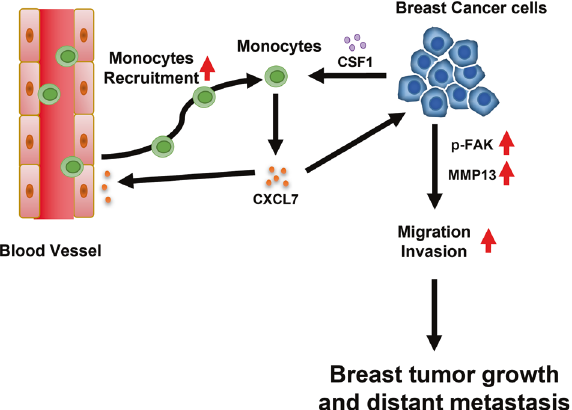
Fig. 6 Current working model of the crosstalk between breast cancer cells and monocytes in the TME. Breast cancer cells secrete CSF1 to stimulate monocytes to secrete CXCL7. CXCL7 subsequently recruits monocytes into the TME and enhances invasive behavior in breast cancer cells, resulting in the promotion of breast tumor growth and distant